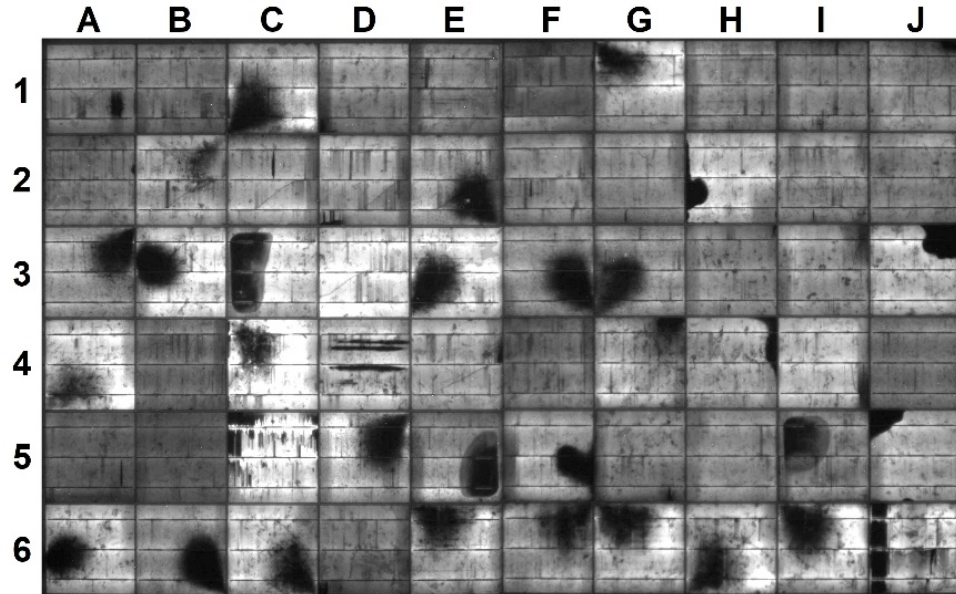
Figure 16. Electroluminescence image of a solar panel with signs of surface contamination. The EL image of the panel shown in Figure 16 shows many cells with the sign of material defect, such cells, e.g., B3, C1, E2, and E3. In addition, several other significant injuries can be observed. A large break reduces the performance of the solar cell on cells H2, J3, and J5. These are cells from which a visibly large part has been broken, which has become inactive and does not produce electricity, so it appears completely black on the image. A unique form of damage called finger interruption can also be applied to cells B2, C2, and D2. Other significantly damaged cells are C5, D4, and J6, which show large areas of inactive parts. This panel operated for four years at a power plant after being replaced during a review due to its insufficient electrical parameters. The air pollution in the vicinity of the solar power plant was high, causing the failure of many modules. The soil and ash samples came from this area. The original peak power of this module was 260 W, while in post-decommissioning laboratory tests, this value was only 233.8 W (89.9%). Figure 17 shows enlarged images of eight cells from the previous image (Figure 16) to make them more visible. We think surface contaminants can further exacerbate existing damage. Tang et al. [30] and Akram et al. [32] reported similarly damaged